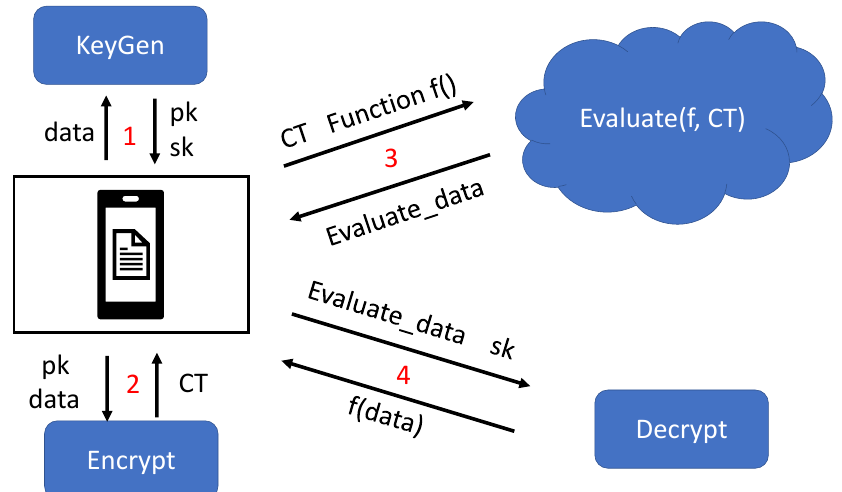
Figure 3. RSS Encryption Chart. Numbers 1-4 of the figure shows the steps for homomorphic encryption to process data. The first step generates public keys (pk) and private keys (sk). The second step uses the public key to encrypt the data. The third step uses ciphertext data (CT) and formulas (Function f()) to calculate and return ciphertext results (Evaluate_data). The fourth step uses the private key to decrypt the ciphertext result, and obtains the calculated result after decryption